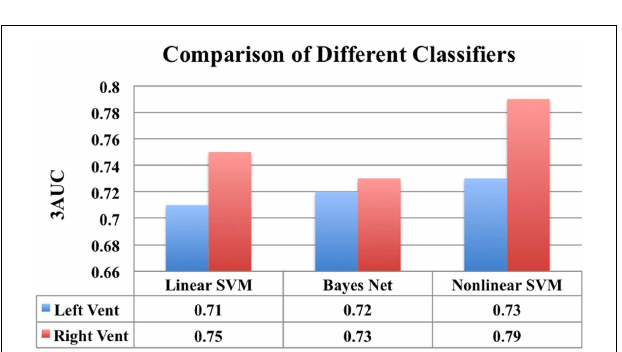
FIGURE 13 |A comparison of classification performance of ventricular displacement features ( N = 5, 10, 20, 50, 100, 200, and 300) w.r.t number for partitions of the surface subdivision